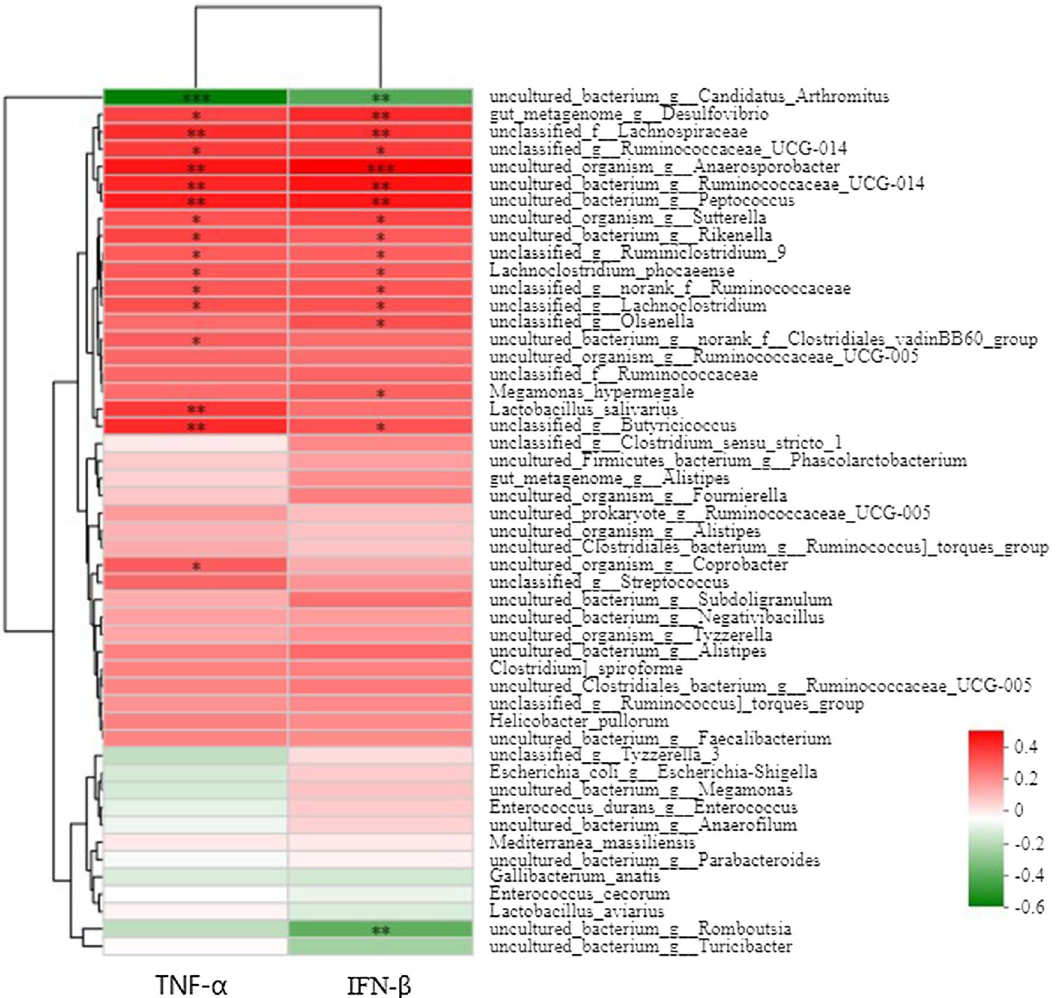
Figure 6. Spearman’s correlation analysis for TNF-α, IFN-β mRNA expression and species of bacteria in ileal mucous membrane. *P < 0.05, **P < 0.01, ***P < 0.001. Relative abundance is indicated by a color gradient from green to red, with green representing low abundance and red representing high